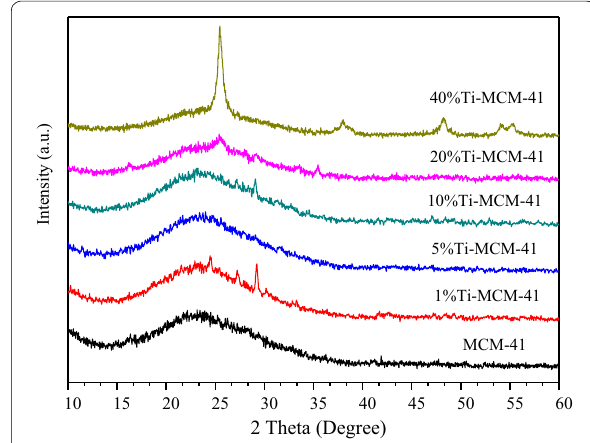
Fig. 2 XRD patterns of the samples (big angle area)